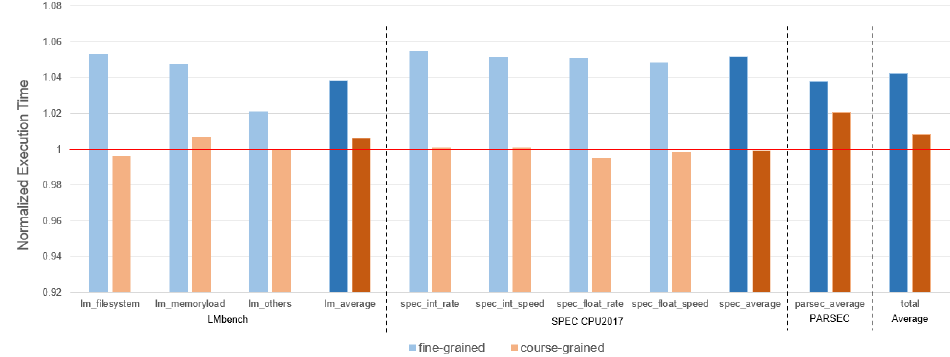
Figure 3. Normalized execution time of SPEC2017, PARSEC and LMBENCH with